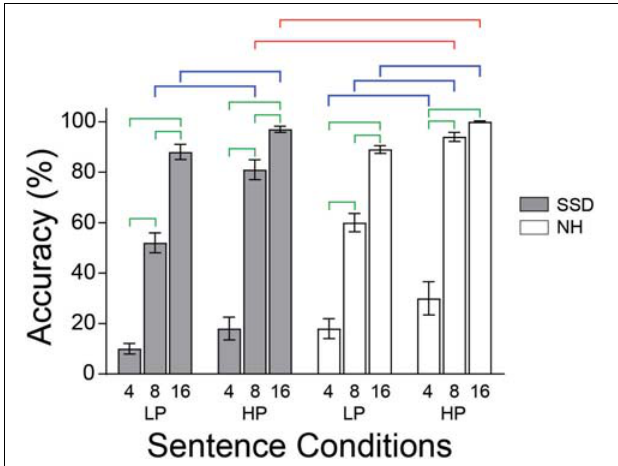
FIGURE 1 | The behavioral study found average accuracies naming sentence last words varied with intelligibility and semantic predictabilities in both groups. Brackets mark bars with significant accuracy differences between intelligibility levels (green), groups (red), and predictabilities (blue). LP, low predictability; HP, high predictability; NH (white bars), normal hearing; SSD (gray bars), single sided deafness. Error bars are